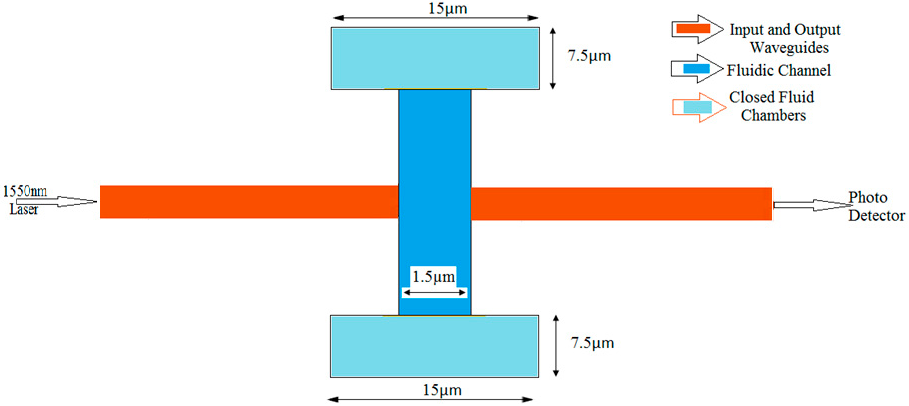
Figure 1. Schematic representation of the integrated biosensor.